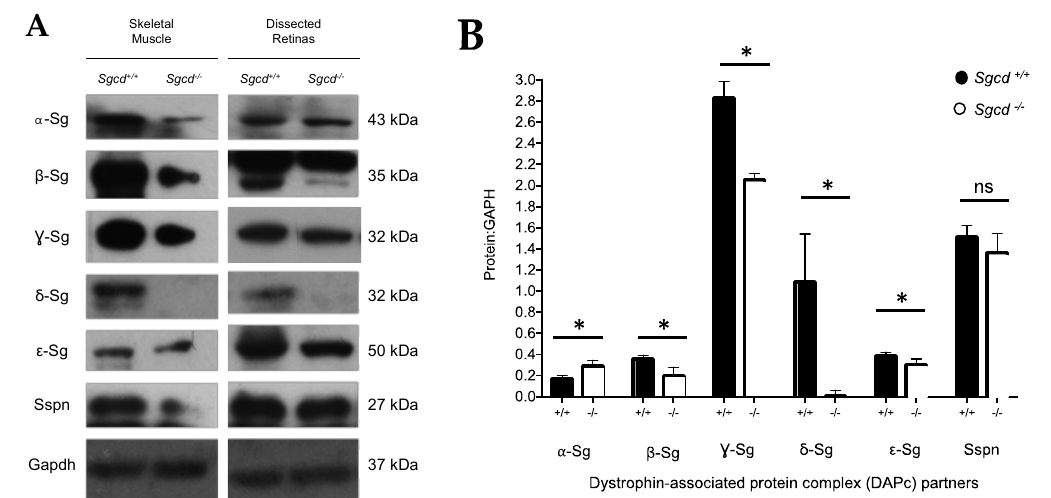
Figure 3. Expression of the Sg-Sspn complex of retinal and skeletal muscle in three-month-old Sgcd − / − ( n = 12) and Sgcd +/+ ( n = 12) mice. ( A ) Western blotting for sarcoglycan–sarcospan protein complex in murine-dissected retinas and skeletal muscle (gastrocnemius). ( B ) Glyceraldehyde 3-phosphate dehydrogenase (Gapdh) normalized protein expression of the complex subunit by genotype. ns: not significant at the 0.05 level; *: p -value > 0.05.